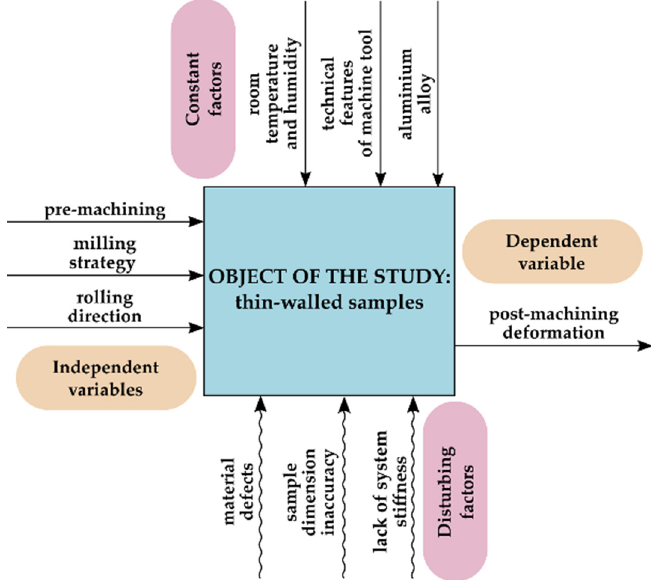
Figure 1. Heuristic model of research object.